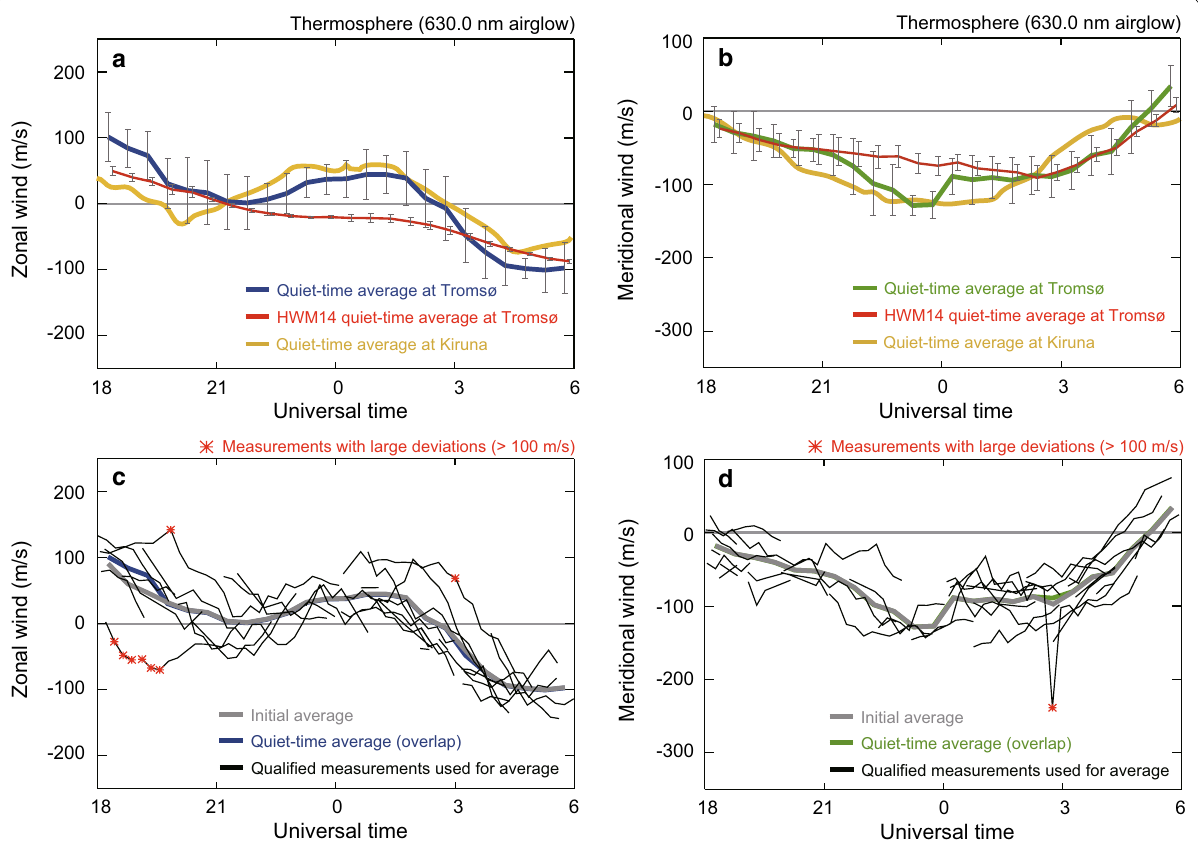
Fig. 2 Nightside quiet‑time average wind in thermosphere (200–300 km) at Tromsø. The data were averaged in 0.5 h bins. a , b Quiet‑time average zonal and meridional winds. In quiet times, the HWM14‑derived average wind at Tromsø and average wind at Kiruna of Aruliah et al. (1999) are also shown. c , d Qualifying measurements satisfying both globally and locally quiet conditions, from which initial average wind (gray) is calculated. Red asterisks indicate those measurements with large deviations (> 100 m/s) from initial average winds, which were removed in calculating the final quiet‑time averages. Note that we artificially shifted the HWM wind to a few minutes later to avoid overlapping error bars, although they were calculated using the same time bins as those for the quiet‑time